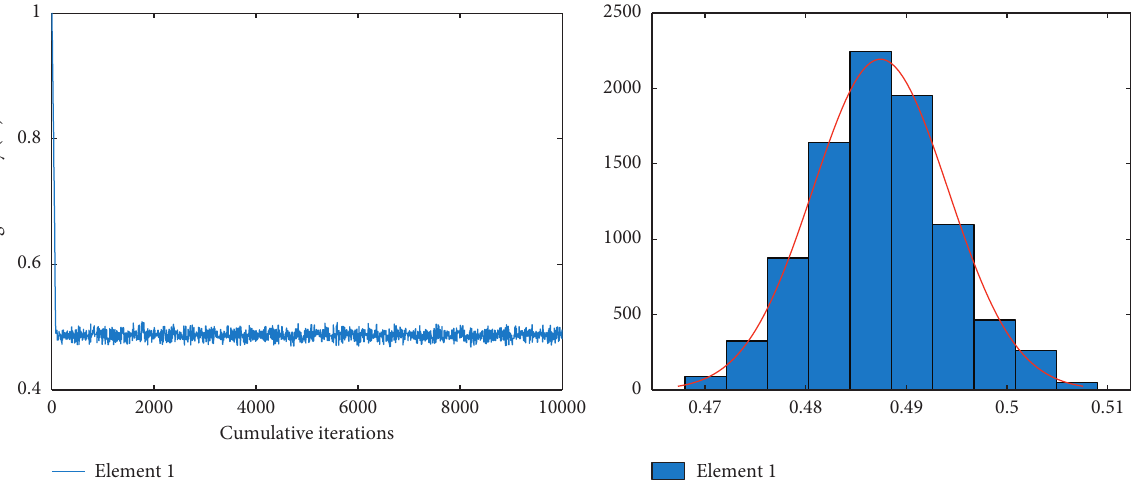
Figure 10: The Markov chains and histograms of damage case 3.